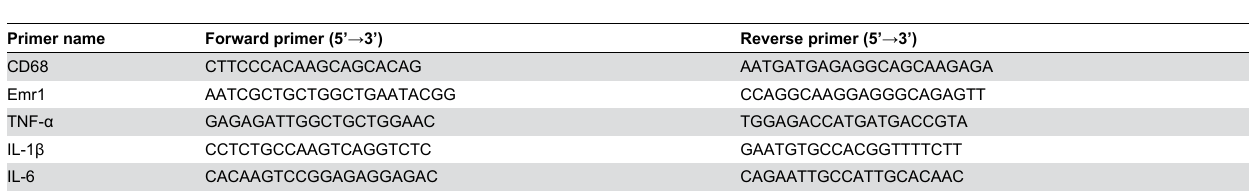
Table 1. Primer sequences for real-time